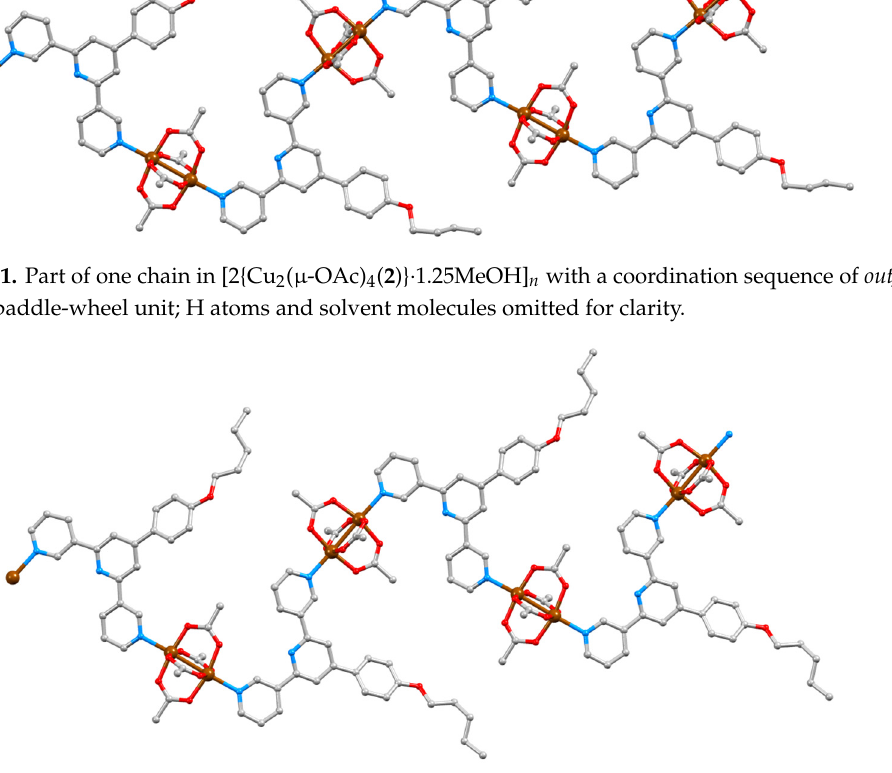
Figure 13. Part of one chain in [{Cu 2 ( μ -OAc) 4 ( 4 )} . 0.2CHCl 3 ] n with a coordination sequence of alternating out/out and in/in at each paddle-wheel unit. The n -heptyl chain is disordered. and only the major occupancy site is shown; H atoms and solvent molecules omitted for clarity. In each of the three structures, the 1D coordination polymer chains pack side-by-side to form 2D sheets. Figure 14 compares the packing of two adjacent chains (each runs left to right in the figure as defined by the blue arrows) in [2{Cu 2 ( μ -OAc) 4 ( 2 )} . 1.25MeOH] n (Figure 14a), [Cu 2 ( μ -OAc) 4 ( 3 )] n (Figure 14b) and [{Cu 2 ( μ -OAc) 4 ( 4 )} . 0.2CHCl 3 ] n (Figure 14c). At first glance, Figure 14a,14b indicate similar packing, but closer inspection reveals a translational shift of chain 2 with respect to chain 1 on going from Figure 14a,b. While the n -butoxy chains are aligned to optimize van der Waals packing interactions (Figures 14a and S17), pairs of n -pentyloxy chains are offset, and a potential interaction is partially interrupted by an acetato methyl group (Figure 14b). The space-filling representation in Figure 14b shows a centrosymmetric embrace between n -pentyloxy and methyl units. With an increase in the length of the alkyloxy tail to n -heptyloxy, the packing of polymer chains in a 2D sheet undergoes a significant change (Figure 14c) with van der Waals interactions between partly extended n -heptyloxy tails being the dominant in-sheet interactions. The cavity visible in Figure 14c is occupied, not by solvent molecules, but by ligands 4 from the next sheet.